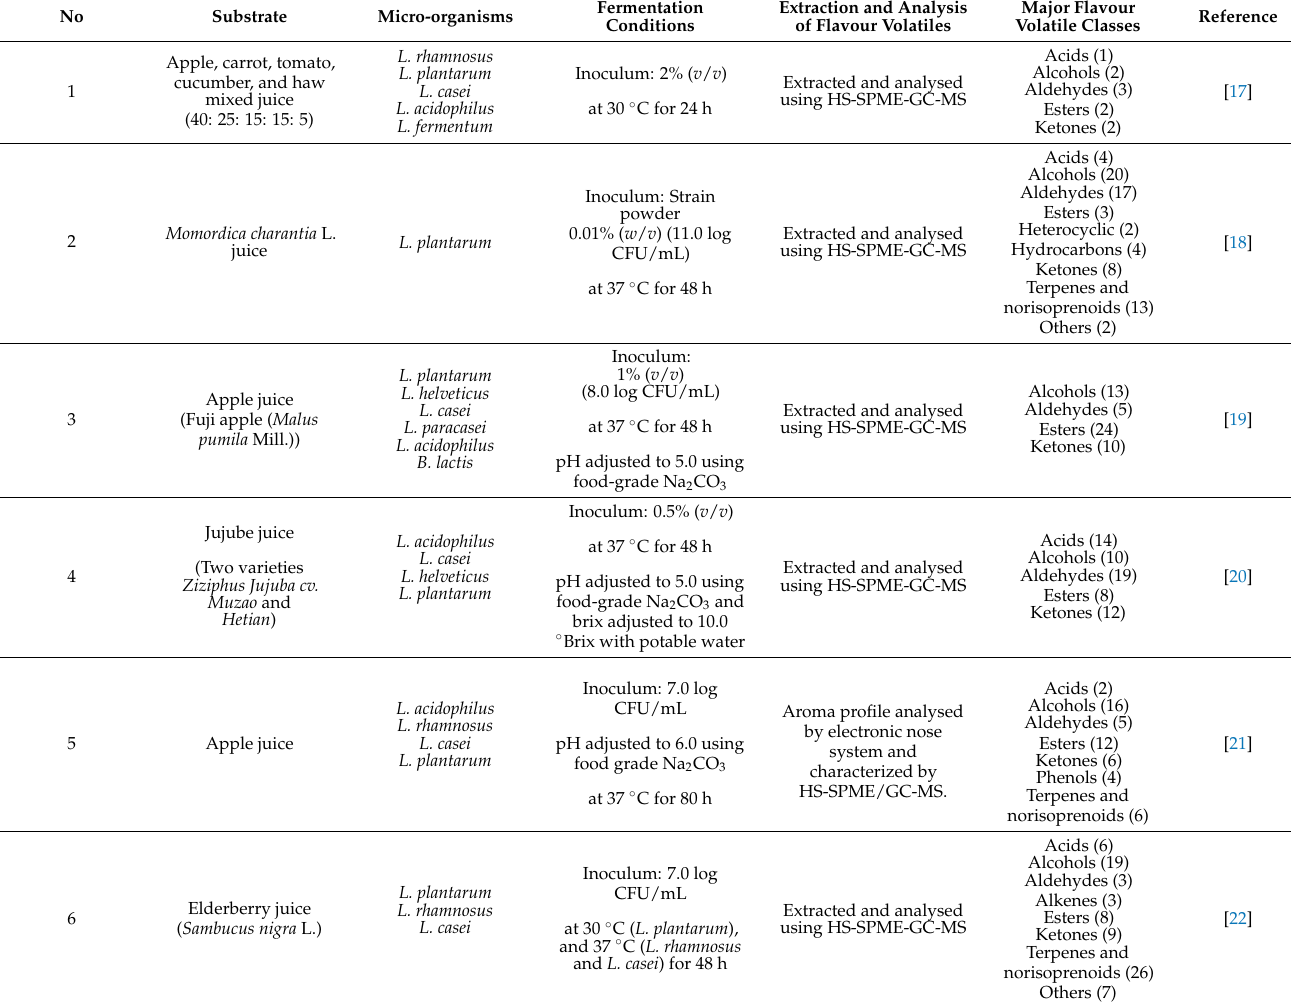
Table 2. Overview of the study conditions used in the 35 papers that met the inclusion criteria on the VOCs associated with fermented vegetable and fruit